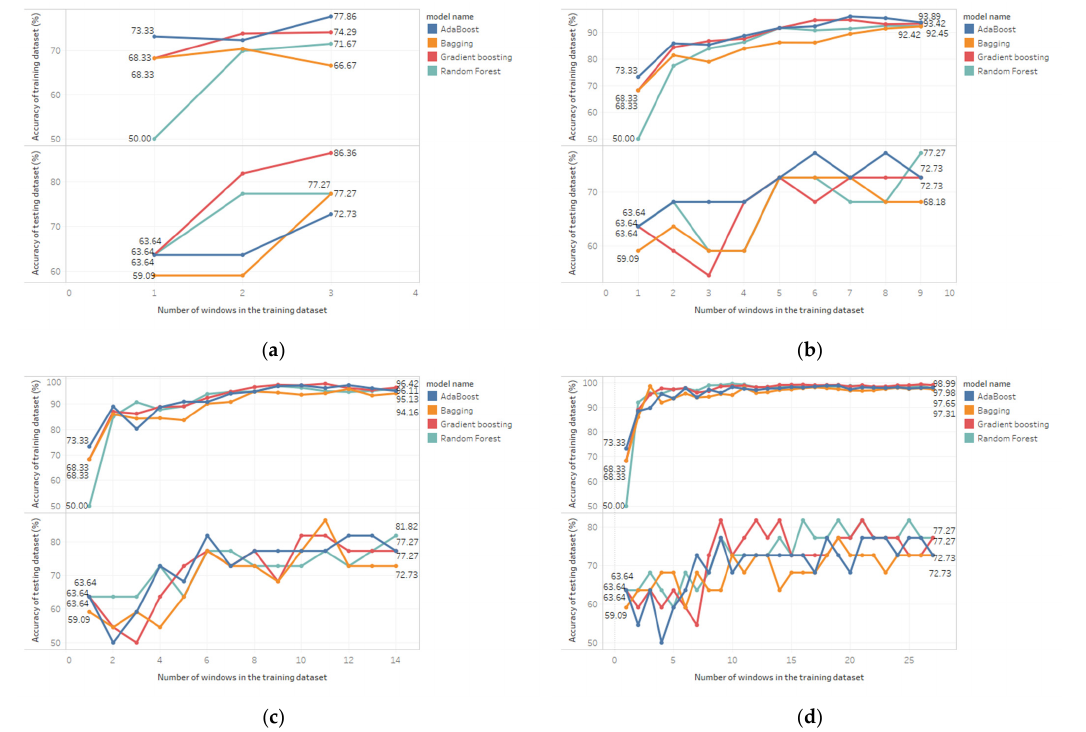
Figure 6. The accuracy of the 4 classification models on training and testing datasets with 29 features using resampling scenario ( a ) RO; ( b ) ROW210; ( c ) ROW240; ( d ) ROW270.